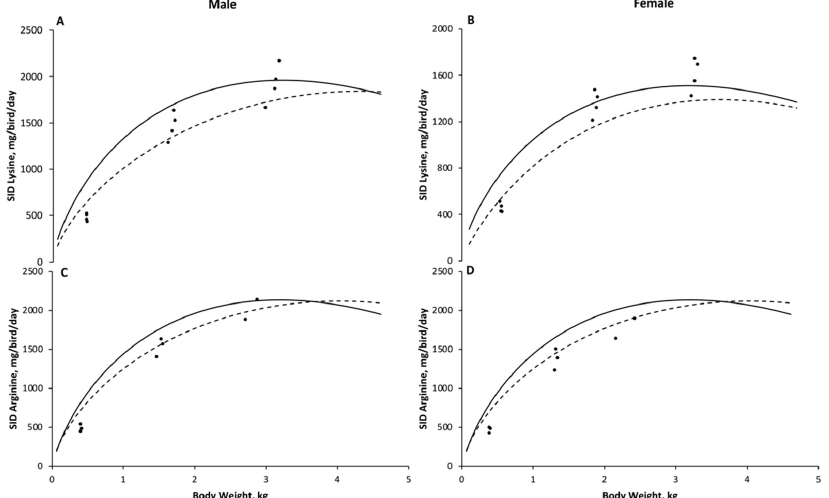
Figure 1. Standardized ileal digestible lysine or arginine intake estimated with model M1 (straight line) or model M2 (dashed line). The Gompertz function was used to generate the inputs for each factorial model. Observed data are represented with dots. Intake of lysine of males ( A ; number of observations = 12, root mean square error (RMSE) for M1 = 269 and M2 = 225), intake of lysine of females ( B ; number of observations = 12, root mean square error (RMSE) for M1 = 189 and M2 = 238), intake of arginine of males ( C ; number of observations = 8, root mean square error (RMSE) for M1 = 237 and M2 = 151), and intake of arginine of females ( D ; number of observations = 8, root mean square error (RMSE) for M1 = 288 and M2 =